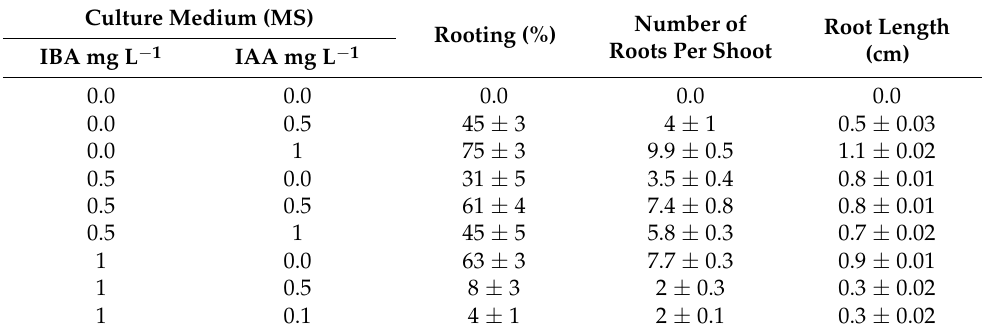
Values represented the mean of three replicates ± standard error. Table 4. Effect of different concentrations of IBA and IAA on root formation of in vitro regenerated shoots of Carum copticum on MS medium.